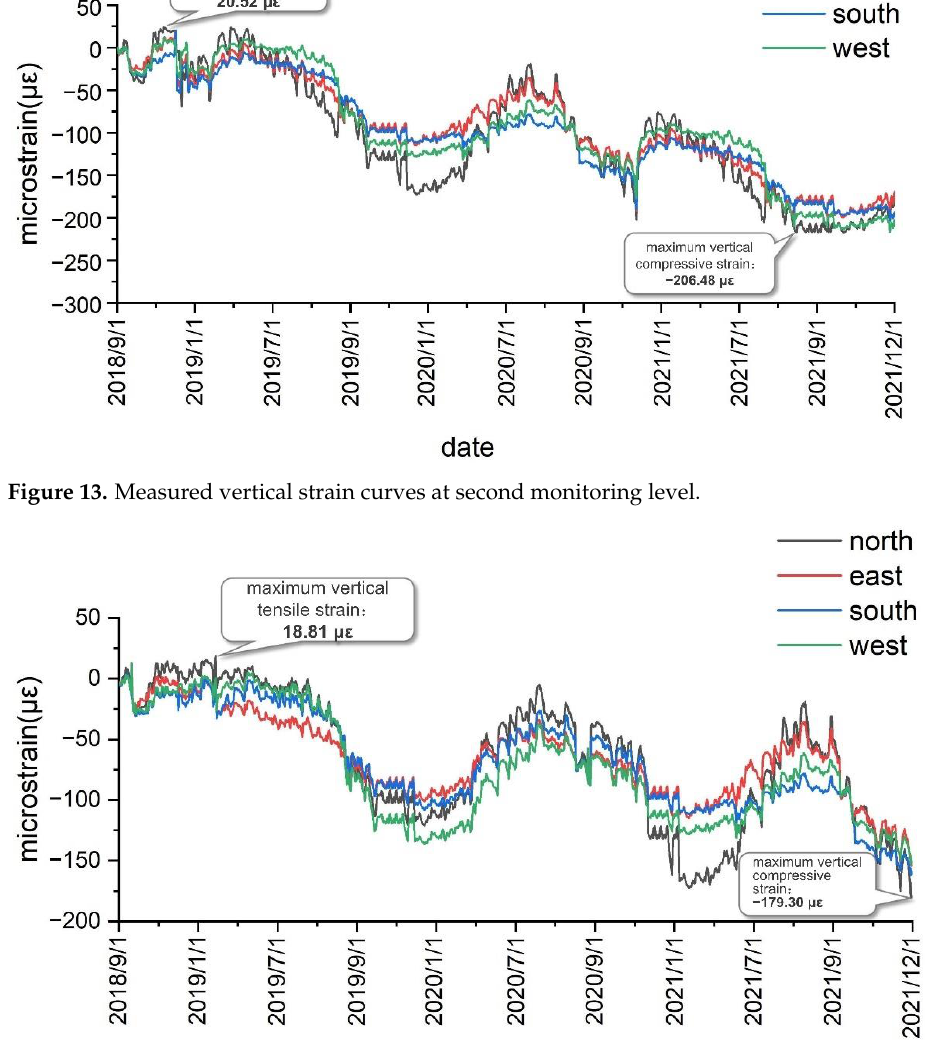
Figure 14. Measured vertical strain curves at third monitoring level.